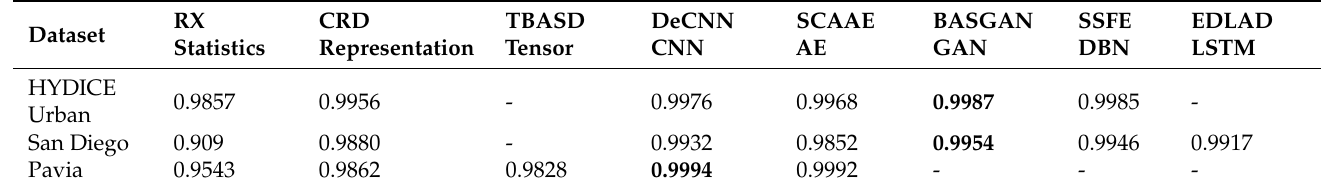
Table 2. AUC comparison between model networks.